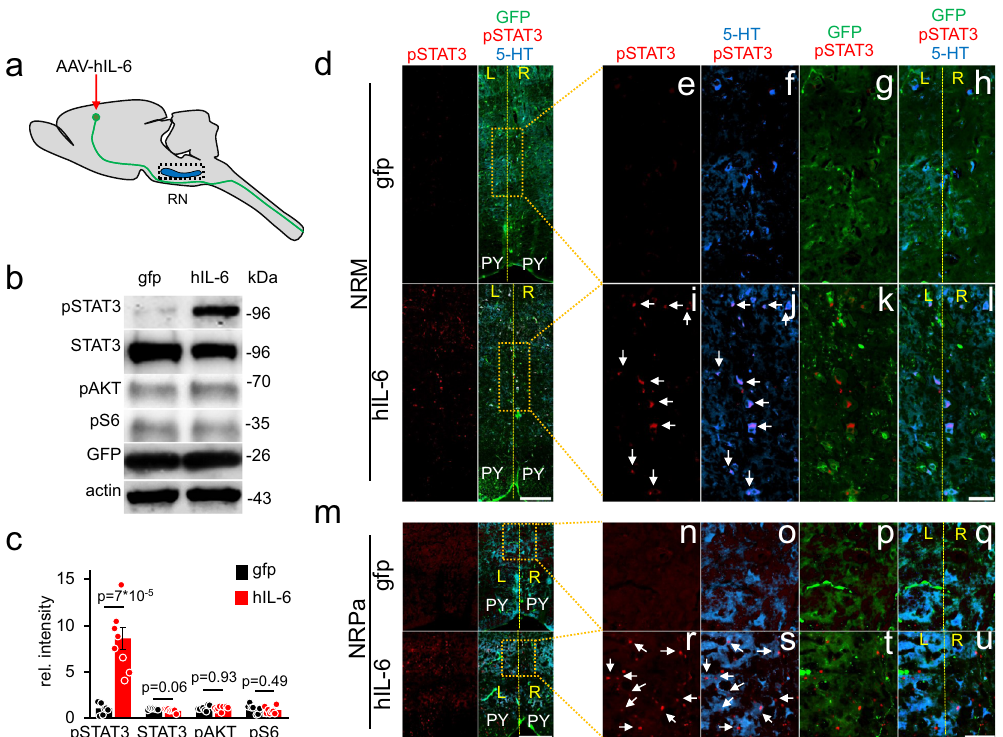
Fig. 6 Hyper-IL-6 transneuronally stimulates neurons of raphe and red nuclei. a Schematic of cortical AAV2-hIL-6 application and isolated brain stem tissue (dashed box) containing the raphe nuclei (RN) for western blot analysis. b Western blots: GFP, total (STAT3) and phosphorylated STAT3 (pSTAT3), phospho-AKT (pAKT), and phospho-S6 (pS6) were analyzed in lysates of the brain stem with raphe nuclei isolated 3 weeks after intracortical injection of either AAV2-GFP (gfp) or AAV2-hIL-6 (hIL-6). GFP signals in lysates veri fi ed similar amounts of transduced collateral axons that projected to the brain stem. Beta-actin served as a loading control. c Densitometric quanti fi cation of western blots from 7 to 8 animals per group (gfp, n = 7; hIL-6, n = 8) as described in ( a ). Data represent means± SEM. d , m Immunostaining of brain stem sections containing the nucleus raphe magnus (NRM, d ), or nucleus raphe pallidus (NRPa, m ) of AAV2-GFP or AAV2-hIL-6 treated mice as described in Fig. 2a. Sections were stained for pSTAT3 (red), GFP (green), and serotonin (5-HT, blue) to identify raphe neurons. The dashed yellow line indicates the midline. We observed a similar amount of pSTAT3 positive serotonergic neurons in the left and right hemisphere of the raphe nuclei from AAV2-hIL6 treated mice ( n = 6). Scale bar: 200 µ m. e , f , n – u Higher magni fi cations of the dotted box as indicated in ( d ) ( e – l ) or ( m ) ( n – u ). Signi fi cances of intergroup differences in ( c ) were evaluated using the two-sided student ’ s t -test and indicated by p -values. Dots in c represent values of samples from single animals. Source data are provided as a Source data fi